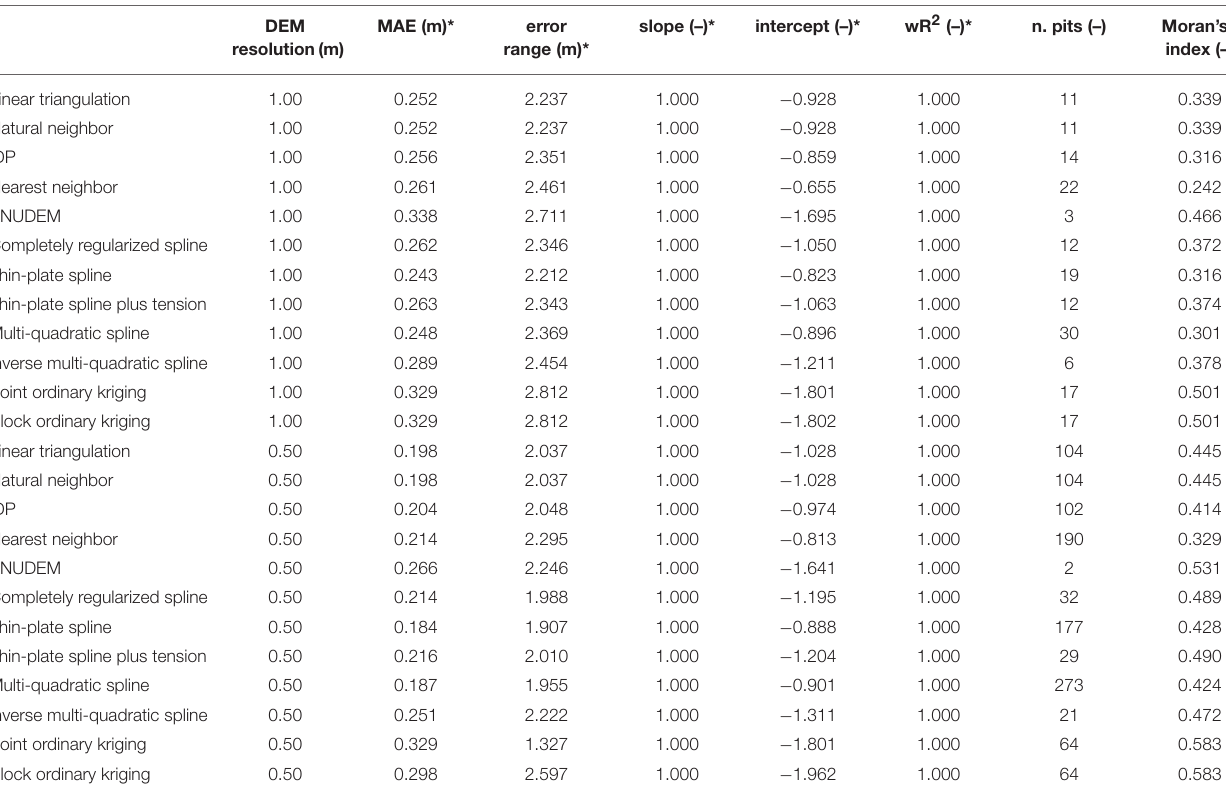
TABLE 3 | Supplementary DEM quality indices and global Moran’I index values for each tested interpolation algorithm and chosen spatial resolution (* the values refer to the errors distribution after the outliers